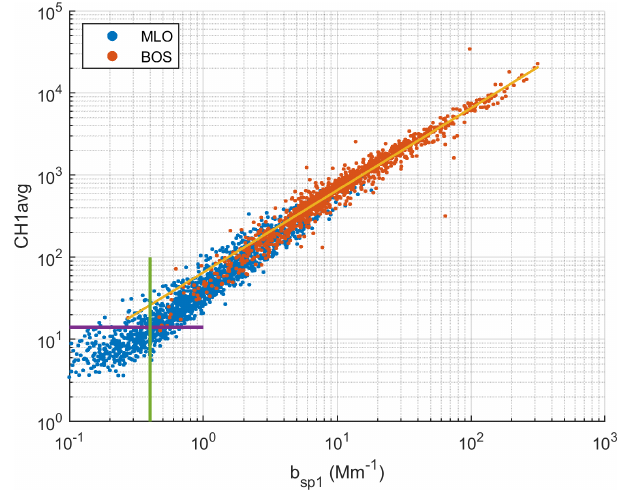
Figure 13. Fine aerosol scattering coefficient from TSI nephelome- ter vs. CH1avg value from PA-PMS. Yellow line represents the fit to all data. The purple line shows the additive uncertainty of 14, while b sp1 values lower than the green line were removed for the regression analysis.